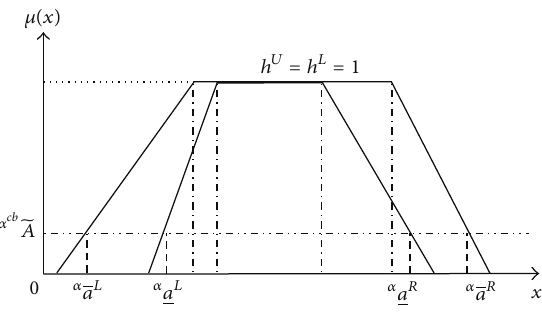
Figure 2: Crisp bounds of